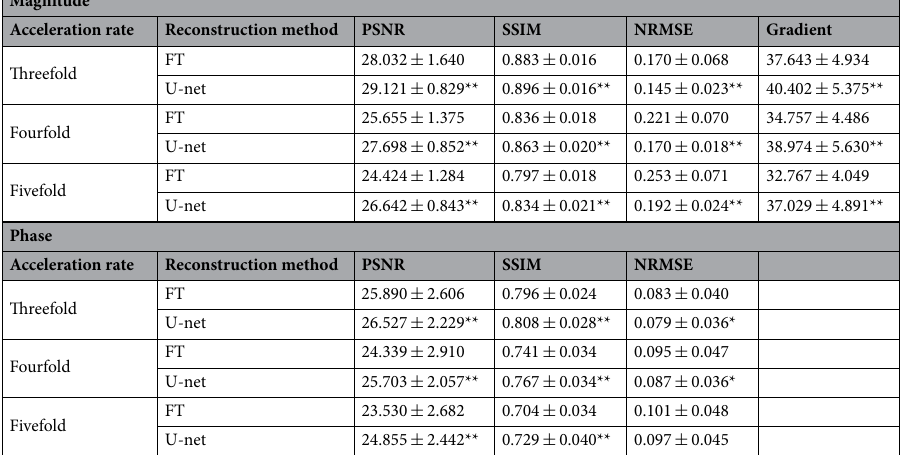
Magnitude Sampling